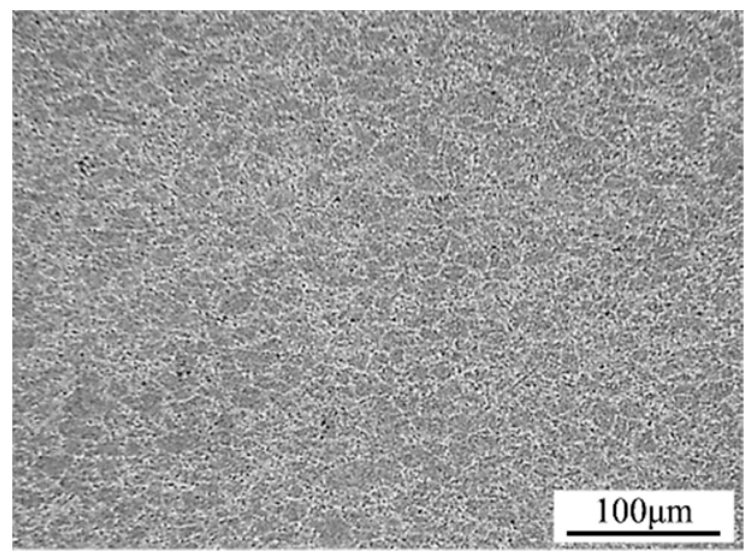
Figure 1. Original microstructure of S280 ultra-high-strength stainless steel.